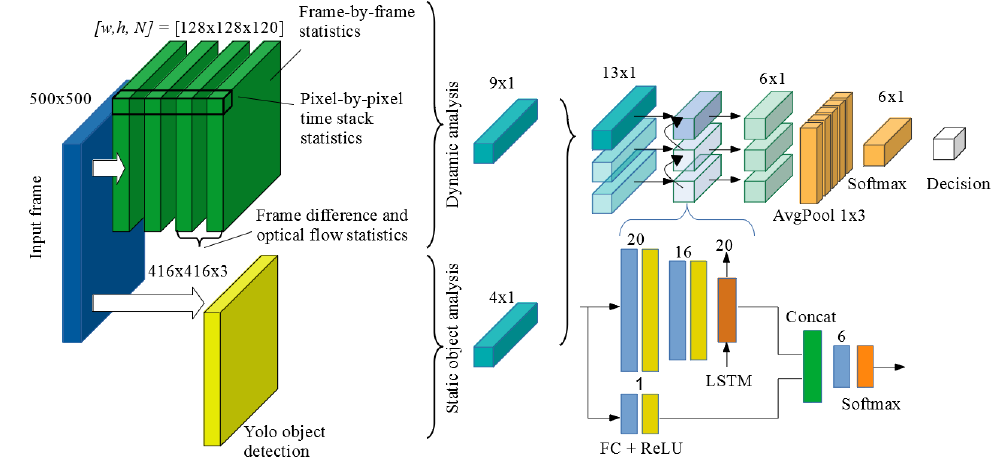
Figure 2. The figure on the left illustrates the collected frame stack size. The central one shows the extracted feature vectors resulting from dynamic and static object analysis. The concatenated vector contains the following 13 features: mean value of image brightness (Equation (1)) and mean value of standard deviation of each frame in the stack (Equation (2)), the average of the absolute value of the difference for each frame pair (Equation (3)), magnitude of dense optical flow averaged for each frame pair in the stack, the maximum of sample (temporal) standard deviation of pixel vectors (Equation (4)), the minimum and maximum value of the one-sample Kolmogorov–Smirnov test of the pixel series, the mean value of the low frequency energy component (Equation (5)), the mean value of the signal-to-noise ratio separated based on frequency range (Equation (6)), and 4 YOLO-v3 detected classes (infant, hand, arm, caring artifacts). The data flow is shown upper right, and the architecture of the classification network lower